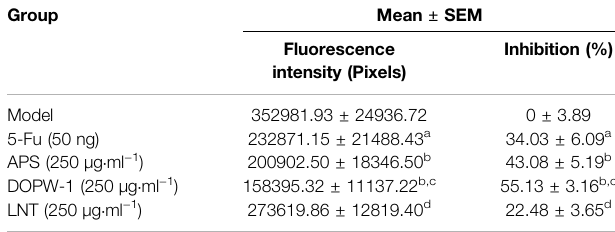
TABLE 3 | Effects of APS, DOPW-1, and LNT on a zebra fi sh xenograft model.